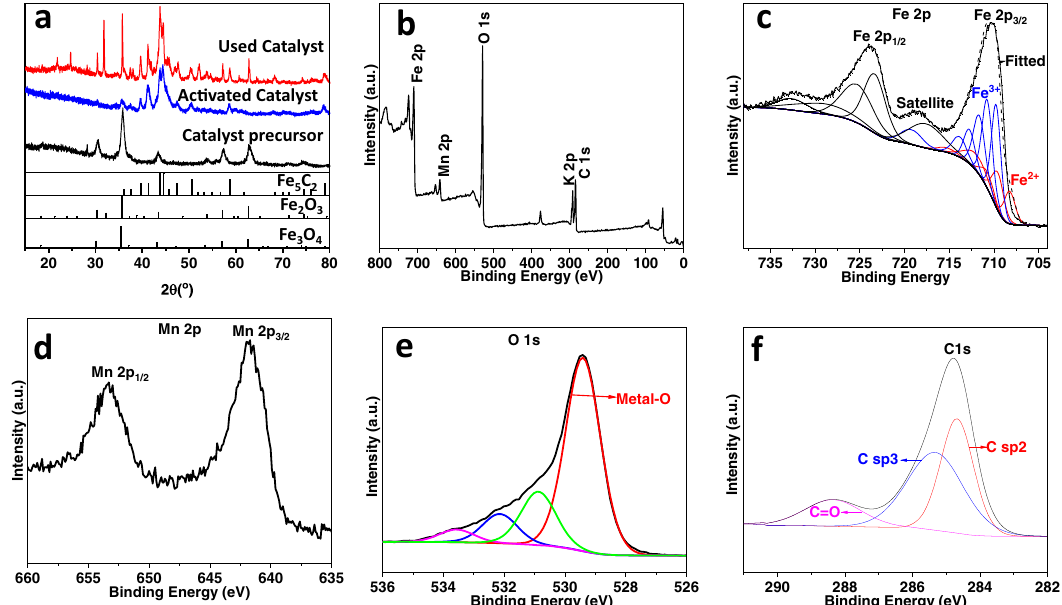
Fig. 2 XRD and XPS spectra of the Fe – Mn – K catalyst. a Powder XRD spectra of the catalyst precursor and both the activated and the used catalyst. The corresponding JCPDS numbers are, for Fe 2 O 3 : 00-020-0508; χ -Fe 5 C 2 : 00-024-0081; Fe 3 O 4 : 03-065-3107; b XPS survey spectrum of the Fe – Mn – K catalyst; c High-resolution XPS spectra in the region of the Fe 2p peak on the Fe – Mn – K catalyst; d XPS spectra of the Mn 2p on the Fe – Mn – K catalyst; e XPS spectra of the O 1s on the Fe – Mn-K catalyst; f XPS spectra of the C 1s on the Fe – Mn – K